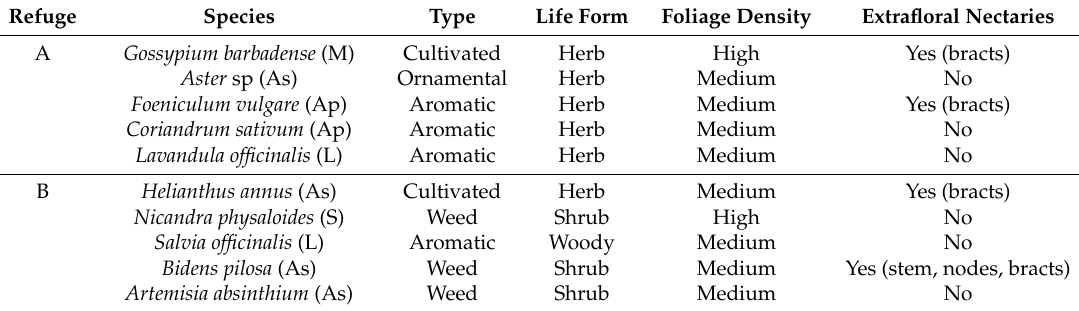
Table 1. Species selected for the refuge patches, including their plant features. Families are indicated between brackets: Apiaceae (Ap), Asteraceae (As), Fabaceae (F), Lamiaceae (L), Malvaceae (M), Poaceae (P), and Solanaceae